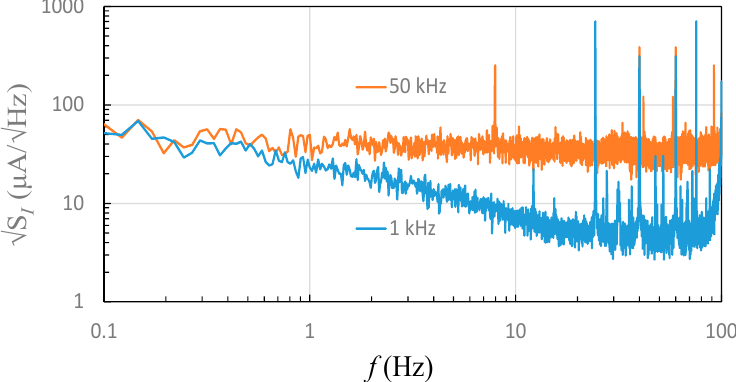
Figure 8. Current noise spectra under 1-kHz and 50-kHz modulation fields under the maximum sensitivity condition.